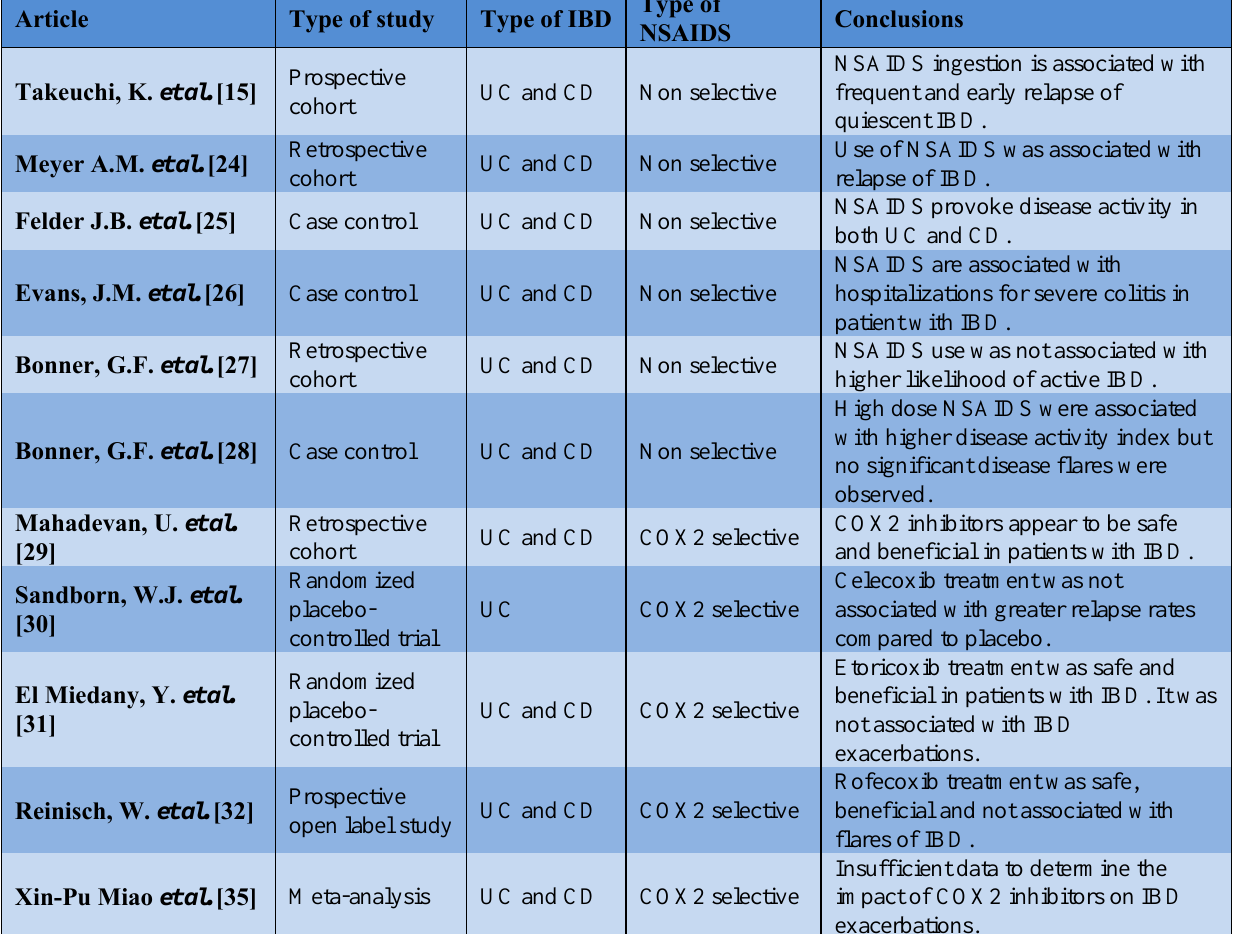
Table 2. Articles on the effect of NSAIDS and selective COX2 inhibitors on